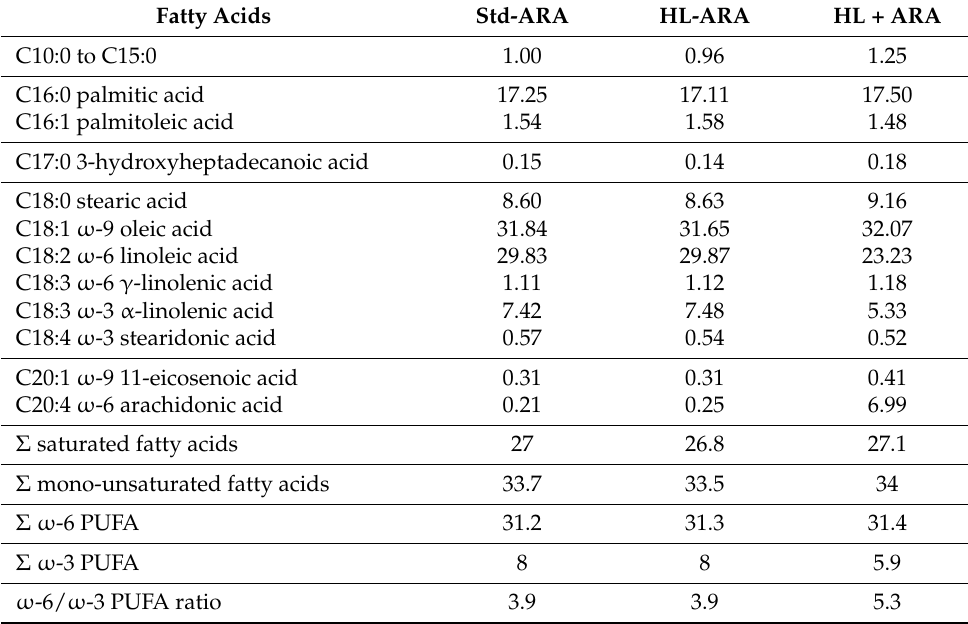
Table 2. Fatty acid composition (% w / w ) of experimental